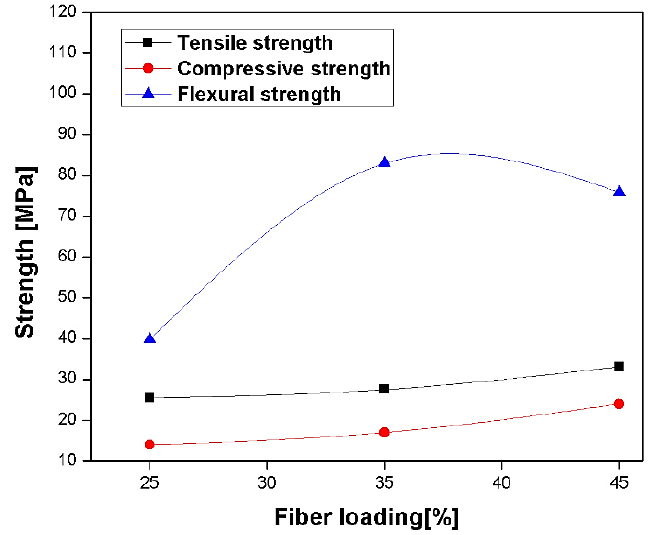
Figure 16. Tensile, Compressive, and Flexural strength of pineapple-reinforced polyester composite at different fiber loading (25, 35, and 45 wt. %). Adapted with permission from Reference [95]. Copyright 2019, with permission from Elsevier.